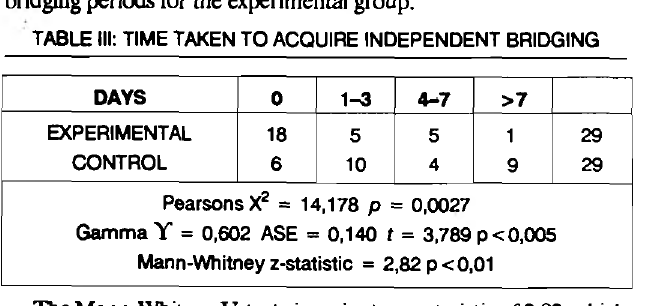
The Mann-Whitney U-test gives rise to a z-statistic of 2,82, which is significantly different from